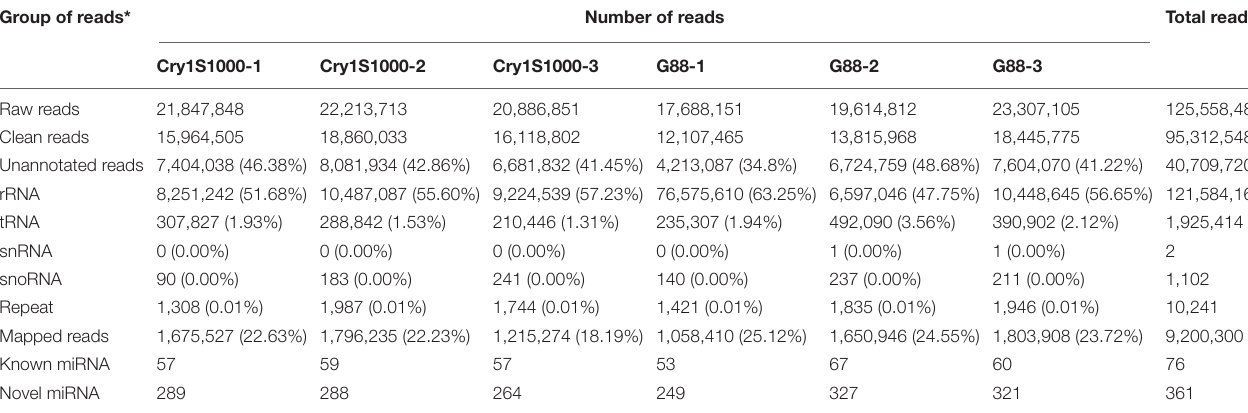
TABLE 1 | sRNA libraries of the Cry1S1000 and G88 strains.